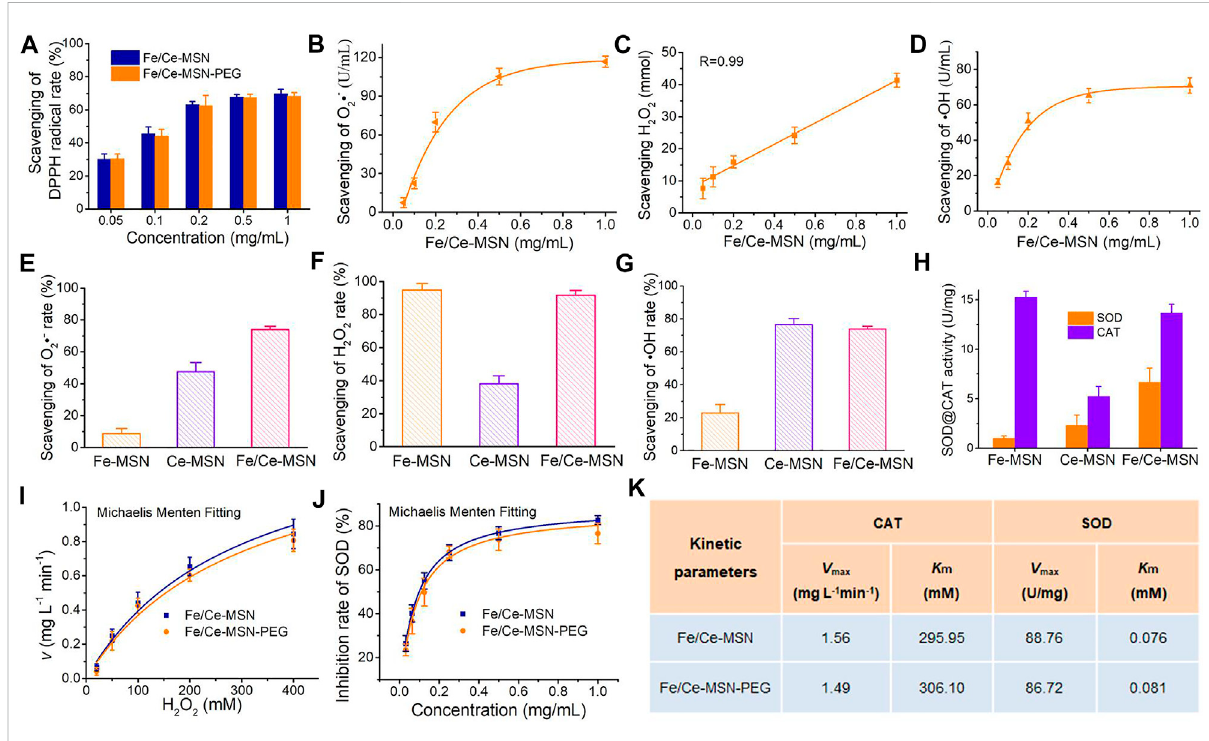
FIGURE 2 ROS-scavenging capabilities of Fe/Ce-MSN NPs. (A) Doses-dependent scavenging of the DPPH radical Fe/Ce-MSN and Fe/Ce-MSN-PEG NPs ( n = 3). (B – D) Elimination of superoxide anion, H 2 O 2 and hydroxyl radical by Fe/Ce-MSN NPs after incubation 8 h. (E – G) Comparison of scavenging capabilities of different materials for radical, superoxide anion, H 2 O 2 and hydroxyl radical. (H) SOD or CAT activity of Fe-MSN, Ce-MSN and Fe/Ce- MSN NPs. Enzyme kinetics of Fe/Ce-MSN and Fe/Ce-MSN-PEG NPs. (I,J) Michaelis Menten kinetic analysis of CAT and SOD activity. (K) ComparisonofthekineticparametersofCATandSODactivity,includingthemaximumreactionvelocity( V max )andMichaelisMentenconstants( K m ), in which K m con fi rms the af fi nity of the nanozyme to the substrate (low K m indicates a high af fi nity) and V max represents the catalytic activity of the nanozyme (Dong et al.,